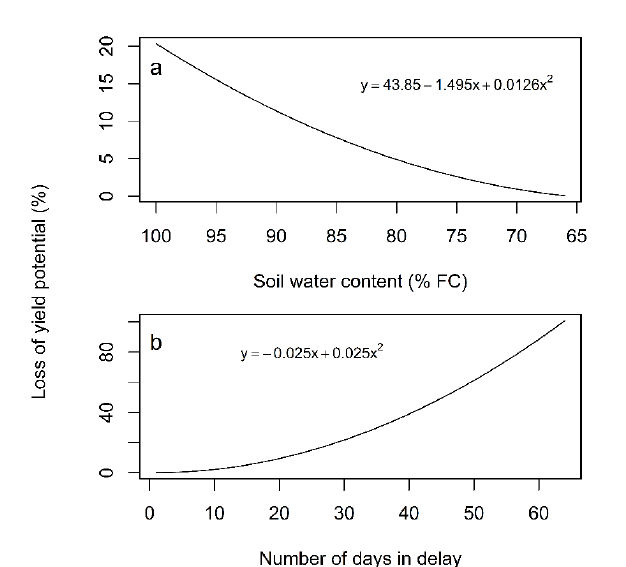
Fig. 2. Functions used for calculation of loss of yield potential affected by (a) soil water content in % of field capacity (FC, –100 hPa) at 0–20 cm soil depth during spring fieldwork, and (b) number of days after optimum sowing date 15 April (Riley 2016; redrawn from Kolberg et al.